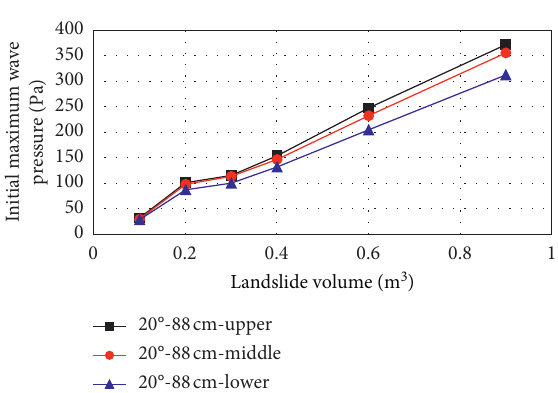
Figure 8: Variation of initial maximum wave pressure at upper, middle,andlowermeasuringpointswithlandslidevolume(20 ° ,88cm).